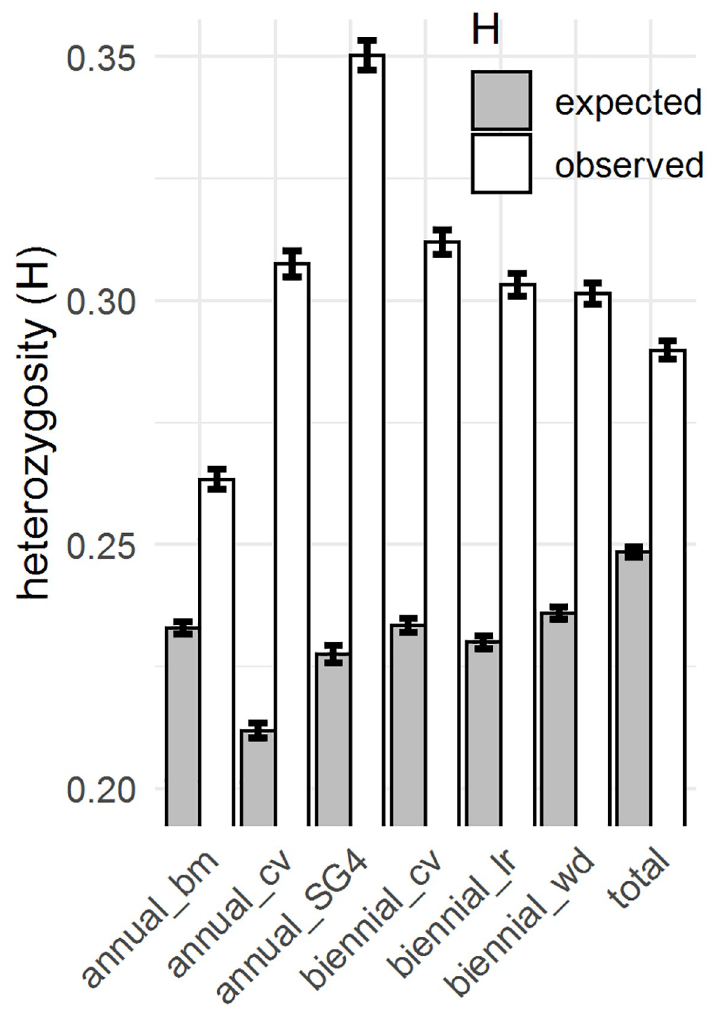
Fig 5. Observed (H O ) and expected heterozygosity (H E ) measured across 13,155 SNP loci for various subsets of caraway accessions. Subsets: 1. Annual breeding material, n = 53. 2. Annual cultivars, n = 6. 3. Annual subgroup SG4, n = 4. 4. Biennial cultivars, n = 19. 5. Biennial landraces, n = 12. 6. Biennial wild material, n = 29. 7. All 137 accessions including non-classified accessions. Error bars = standard errors. Das [19] published a 4C DNA content of 19.051pg (9.526 pg/2C) using Feulgen cytophotome-